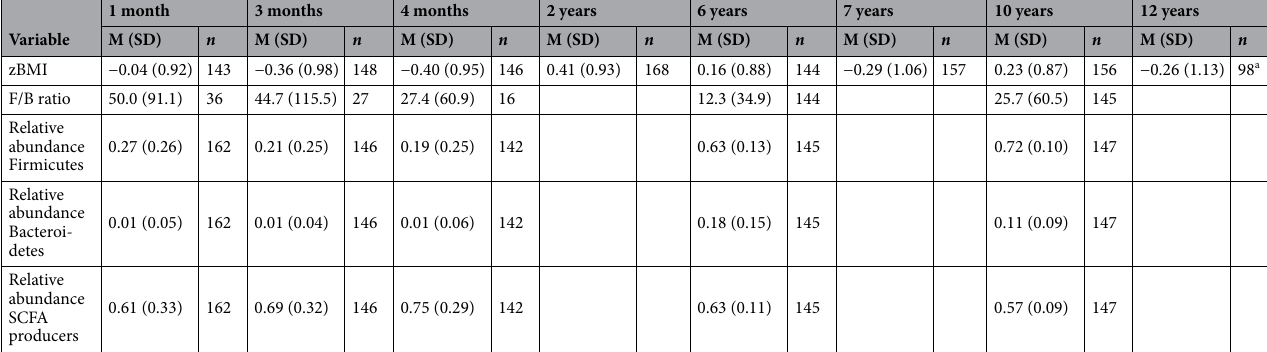
Table 3. Descriptive statistics. Mean (M), standard deviation (SD) and sample size ( n ) are given per variable at each time point. a The sample size for BMI was reduced at 12 years of age because measurement took place during a lab visit including an functional magnetic resonance imaging (fMRI) scan for which not all children met the inclusion